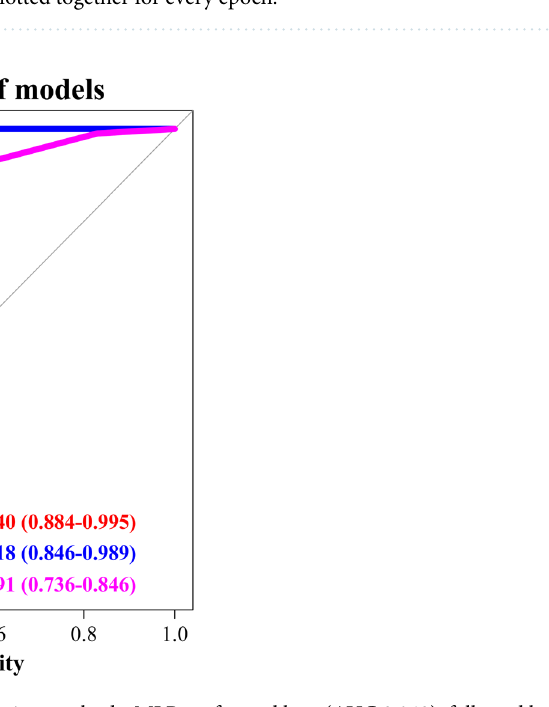
Figure 2. ROC and AUC of machine learning methods. MLP performed best (AUC 0.940), followed by random forest (AUC 0.918) and disc shape alone (AUC 0.630). MLP multilayer perceptron, RF random forest, ds shape of the disc.